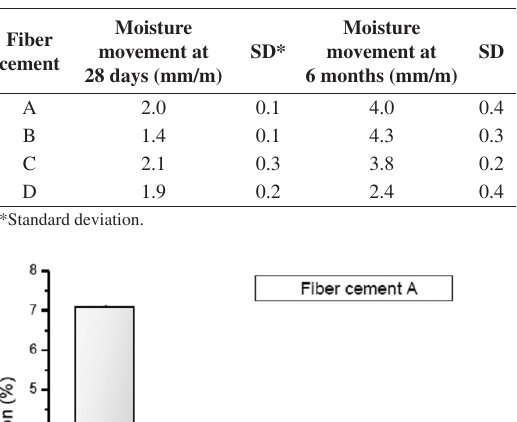
Figure 3. Water absorption evolution up to 28 days – fiber cement C.